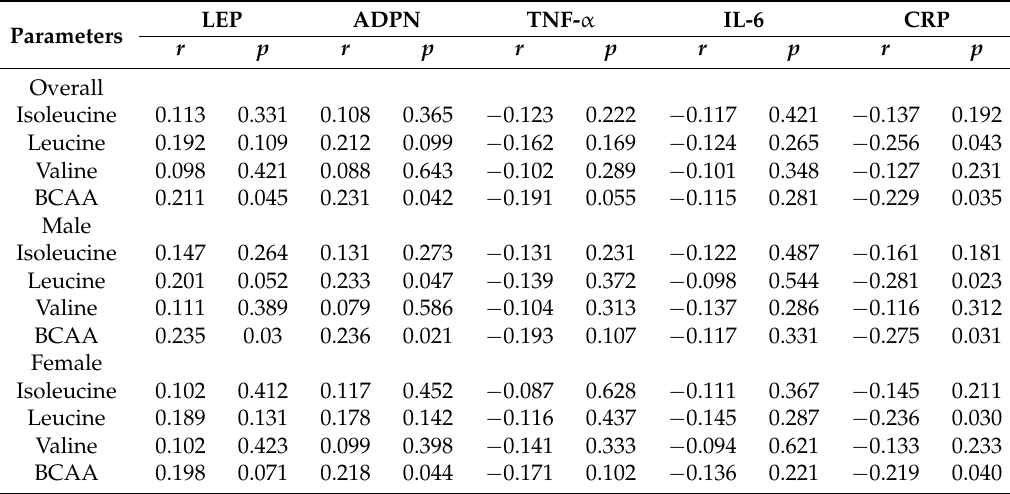
Table 5. Partial correlation analysis of ratio of BCAAs, isoleucine, leucine, and valine and level of